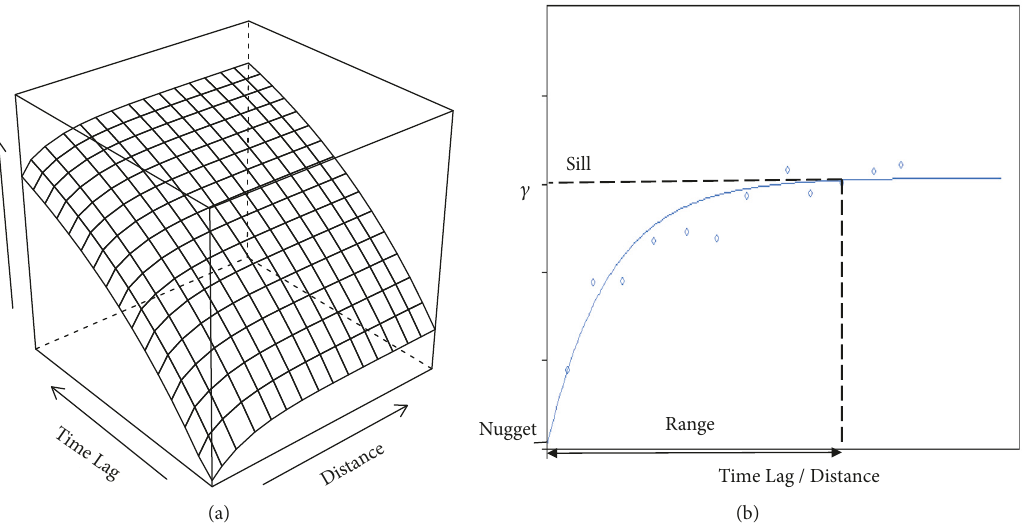
Figure 1: Spatiotemporal variogram. (a) Three-dimensional spatiotemporal variogram. (b) Two-dimensional variogram.